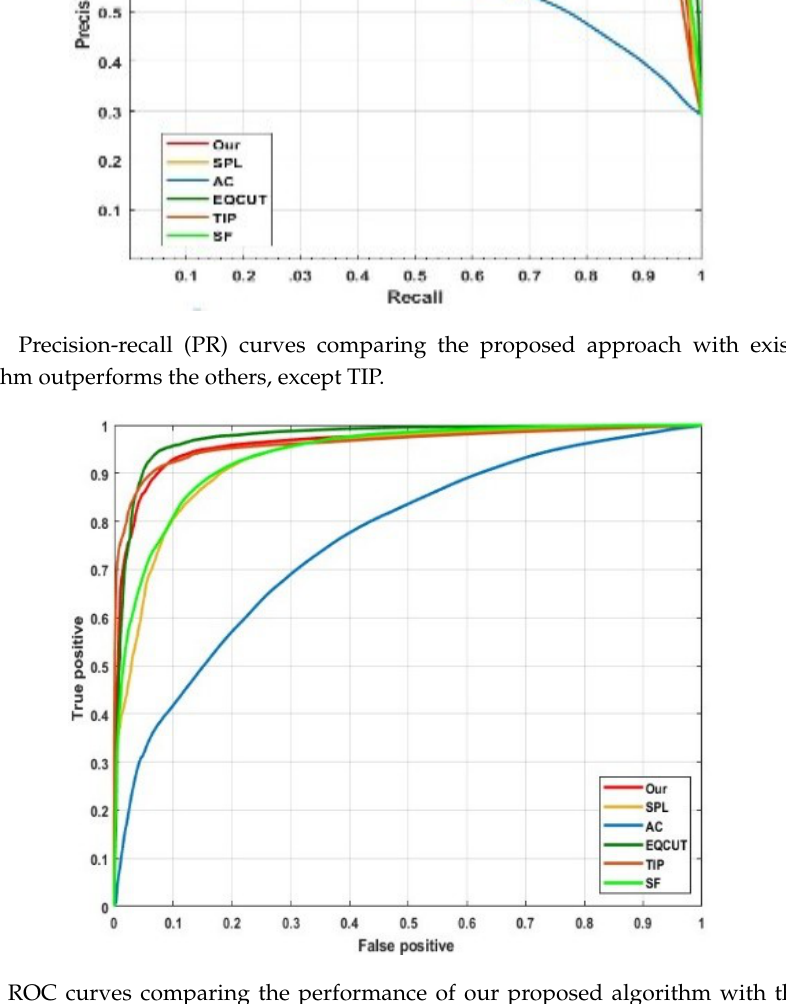
Figure 12. ROC curves comparing the performance of our proposed algorithm with that of five state- of-the-art models.